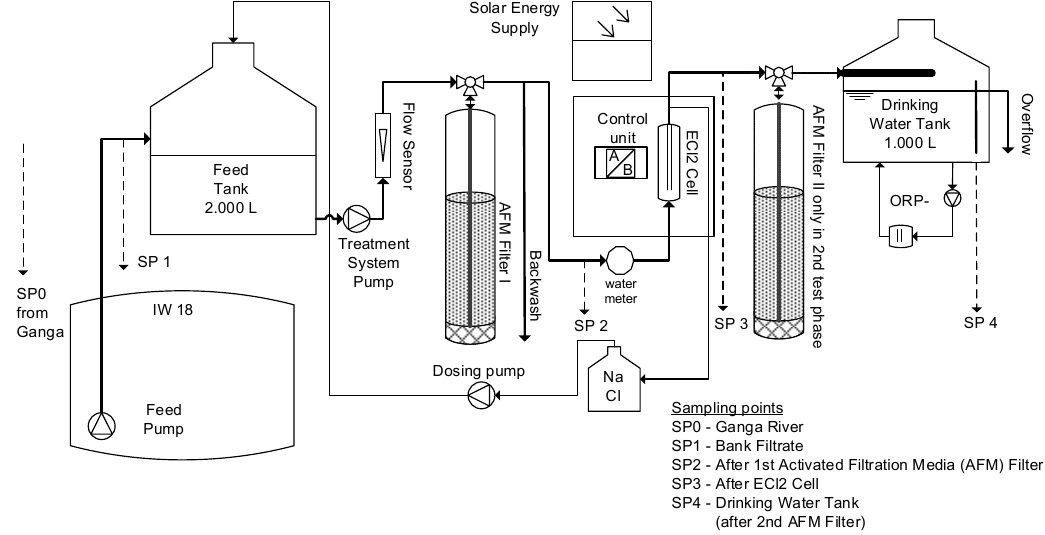
Figure 2. Pilot system setting at well IW #18, Haridwar.